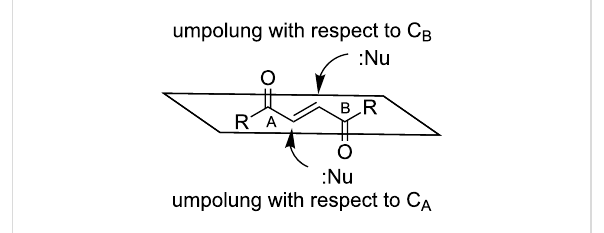
Figure 1: The conjugated addition to unsaturated 1,4-diketone 1